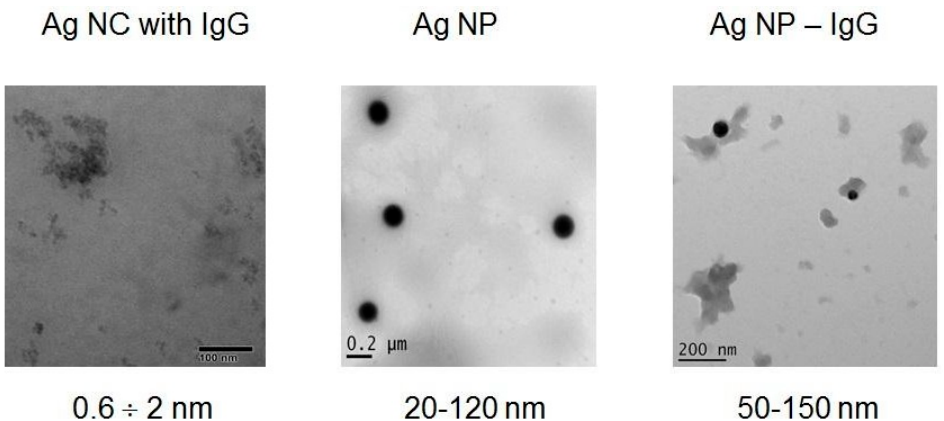
Figure 1. TEM images with size ranges for Ag NCs with IgG, citrate coated Ag NPs and nanoconju- gates of Ag NPs with IgG.